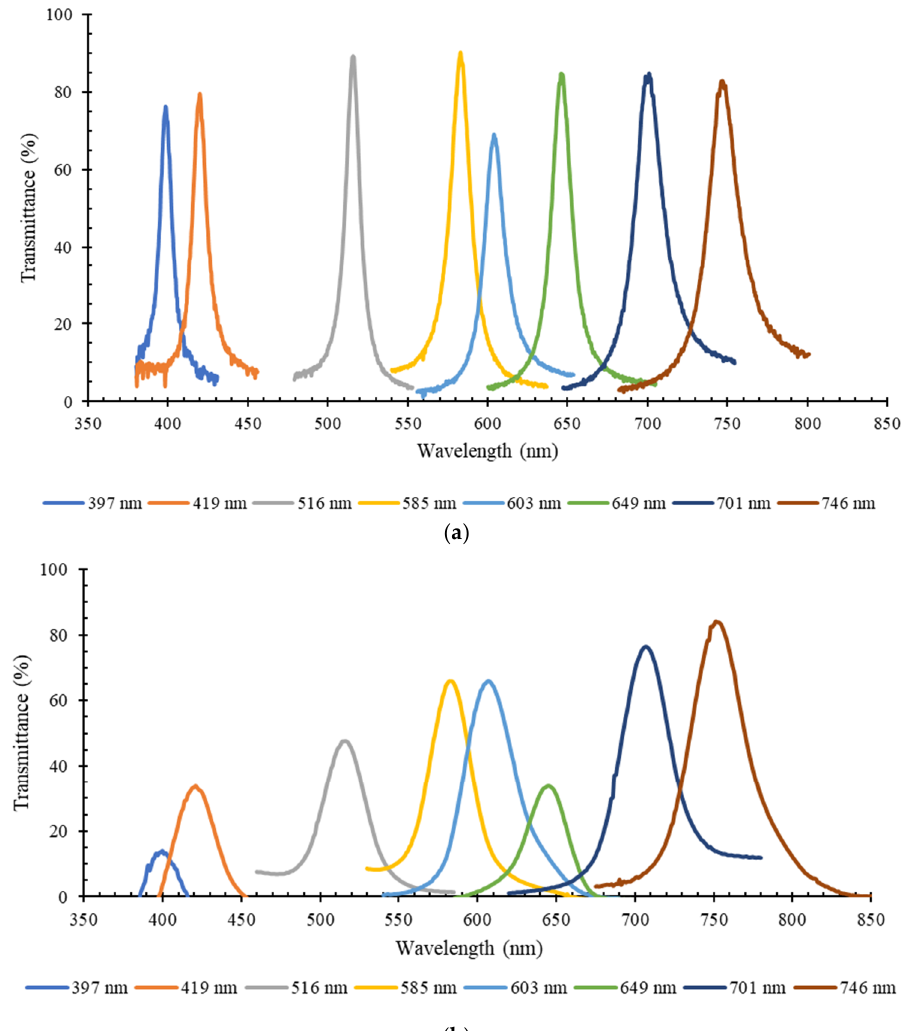
Figure 7. Experimental results ( n = 3) of transmittance (%) vs. wavelength (nm), for the 8 MgO/TiO 2 and SiO 2 /TiO 2 optical filters, measured with a spectrophotometric top bench setup: ( a ) without using additional commercial filters; ( b ) using commercial short pass and long pass filters to remove high transmittance components outside the relevant spectral bands.